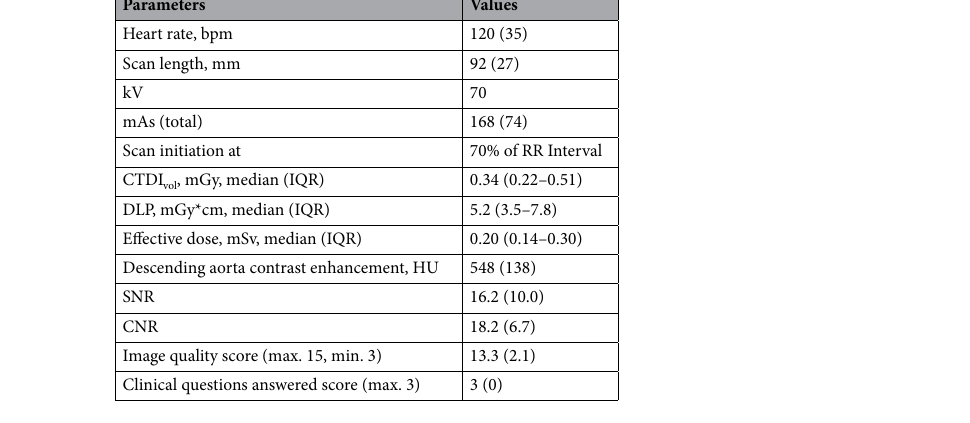
Table 3. Patient characteristics and